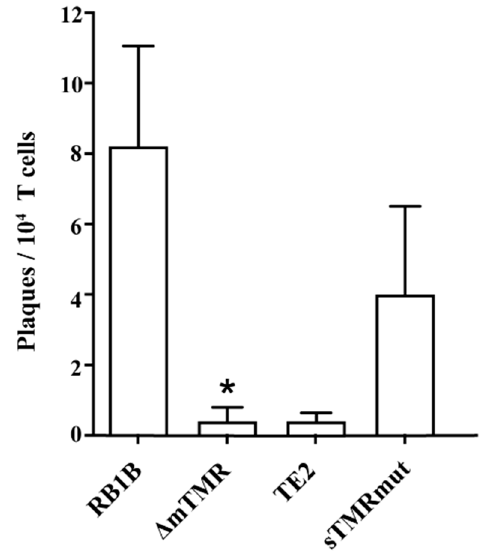
Figure 4. Reactivation efficiency in latently infected 855-19 T cells (14 dpi) infected with the indicated viruses. The data are shown as the mean number of plaques per 10,000 treated T cells on the CEC monolayer (* p < 0.05, Kruskal–Wallis test, n = 3). The error bars indicate the SEM.